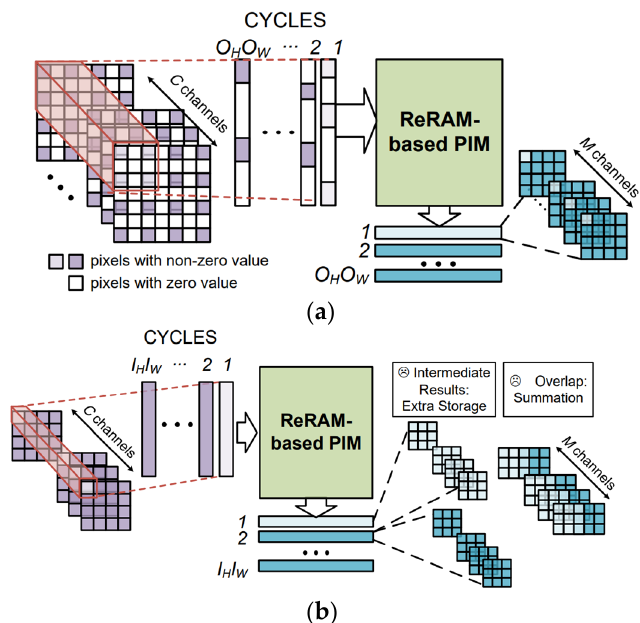
Figure 2. Limitations of the deconvolution algorithm. ( a ) Zero padding and ( b ) padding ‐ free